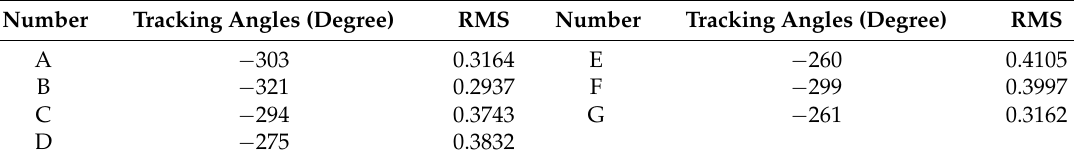
Table 2. Steady state RMS errors of each tracking angle for azimuth